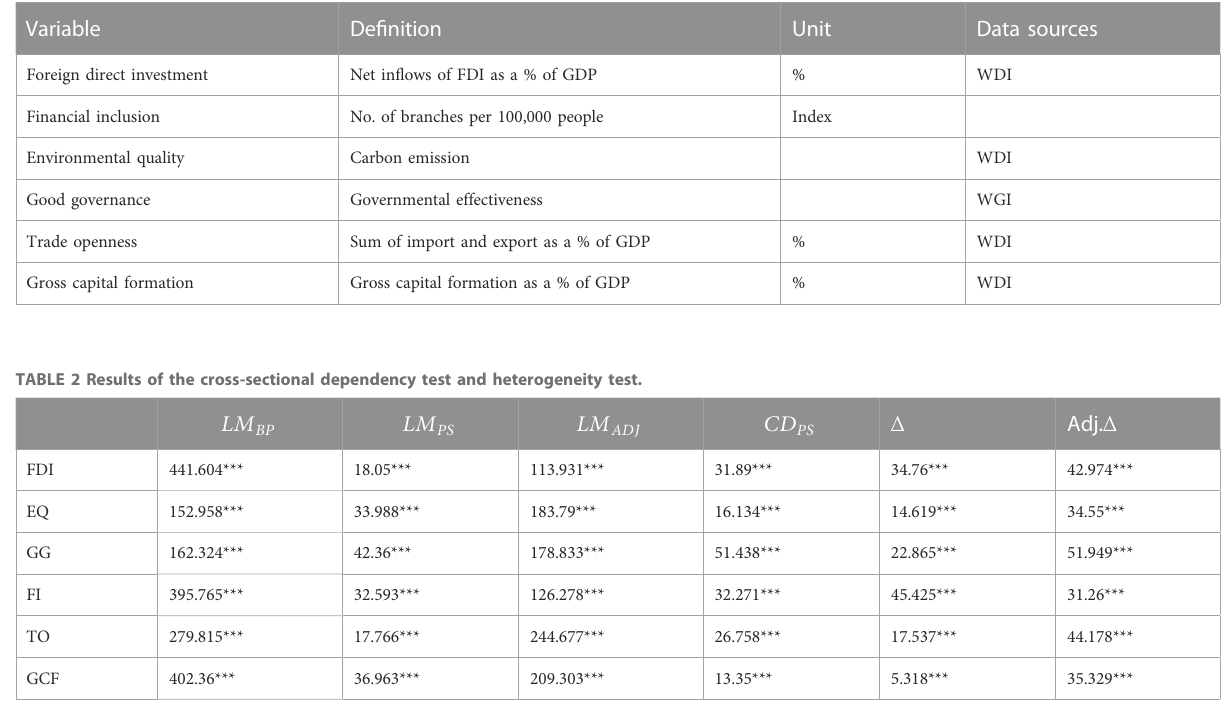
TABLE 1 Variable proxies and data sources.